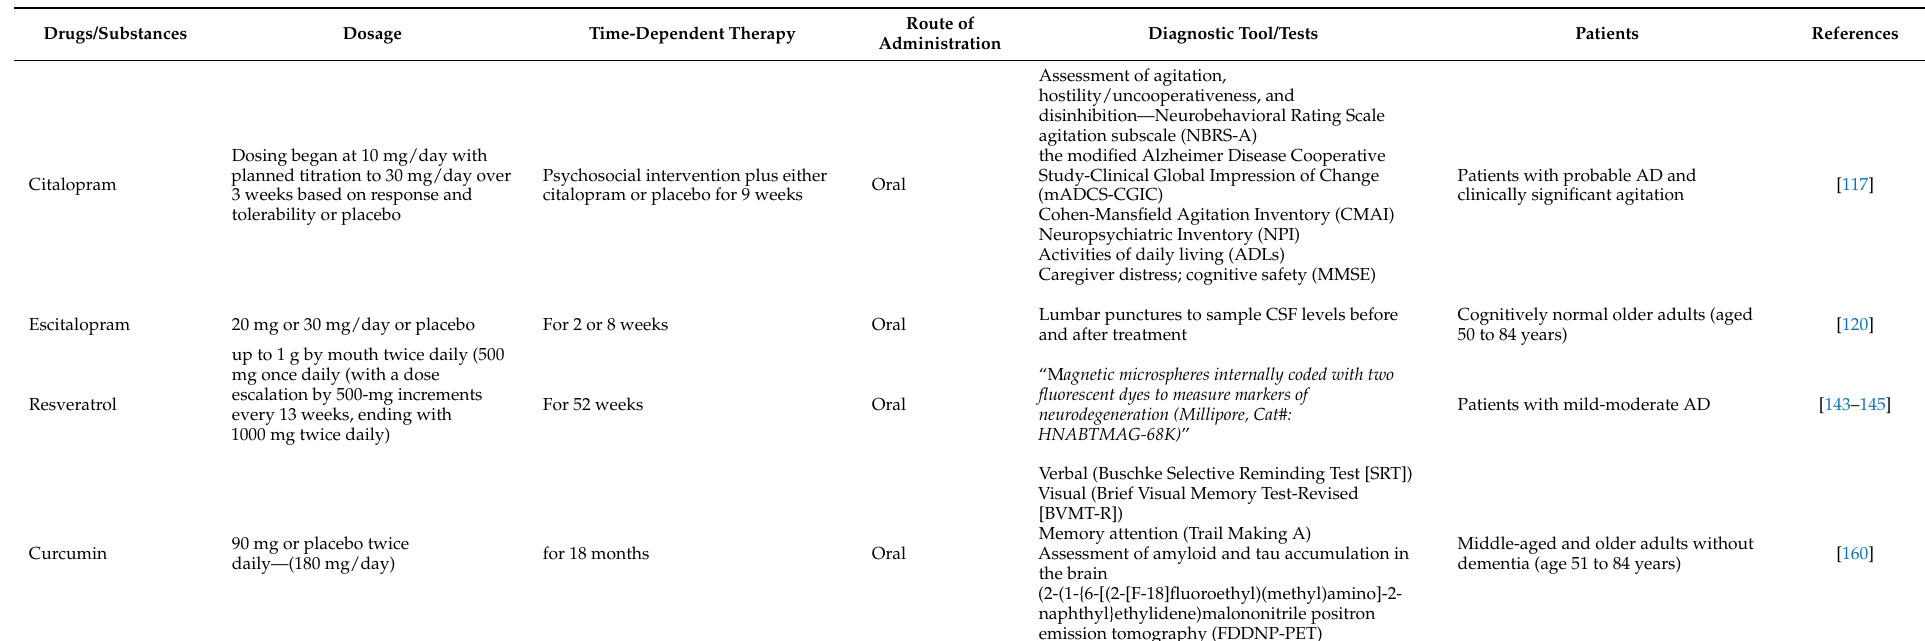
Table 3. Candidate drugs in selected clinical